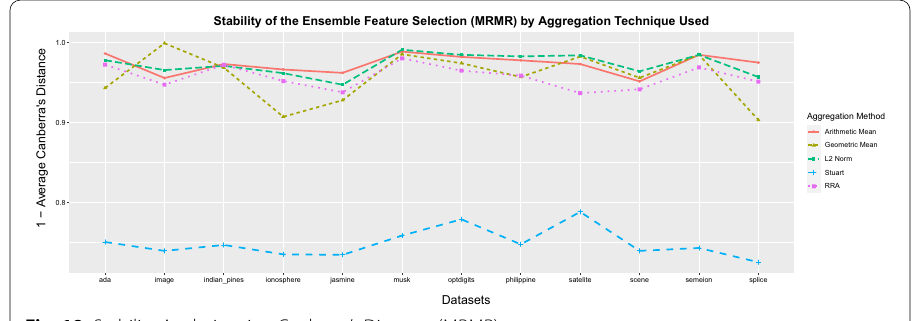
Fig. 18 Stability Analysis using Canberra’s Distance (MRMR)